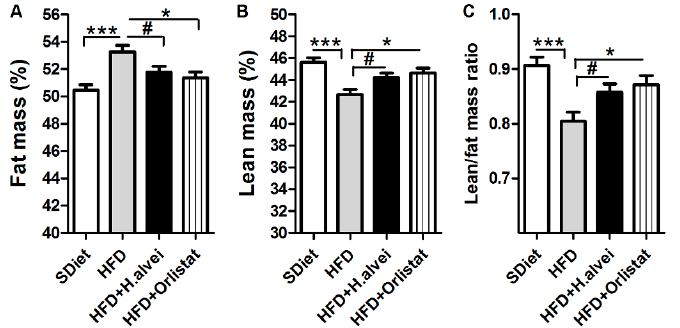
Figure 4. Effects of H. alvei HA4597™ and orlistat on body composition in high-fat-diet (HFD)-fed ob / ob mice as compared to standard diet (SDiet). Percentage of fat ( A ) and lean ( B ) mass, as well as lean / fat mass ratio ( C ) at the end of the treatment. ( A , C ) ANOVA, p = 0.0004, ( B ) ANOVA, p = 0.0002, Bonferroni’s posttests, *** p < 0.001, * p < 0.05. ( A – C ) Student’s t -tests, # p < 0.05, (mean ± SEM; SDiet, n = 16, all other groups, n = 24).